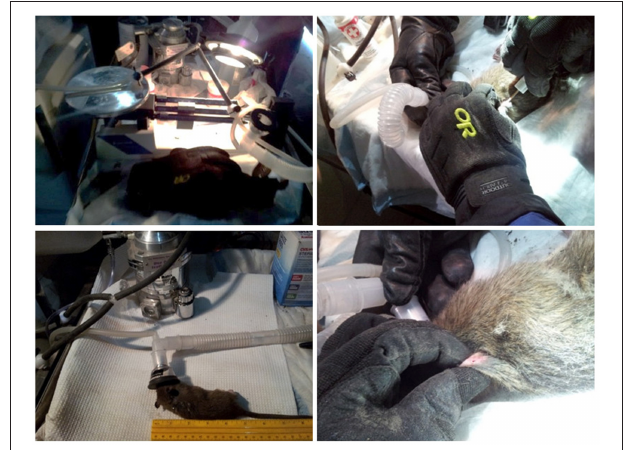
FIGURE 2 | Surgical table and implant procedure for wild Norway rats, Rattus norvegicus , captured on Eastern Long Island and monitored from January 14–May